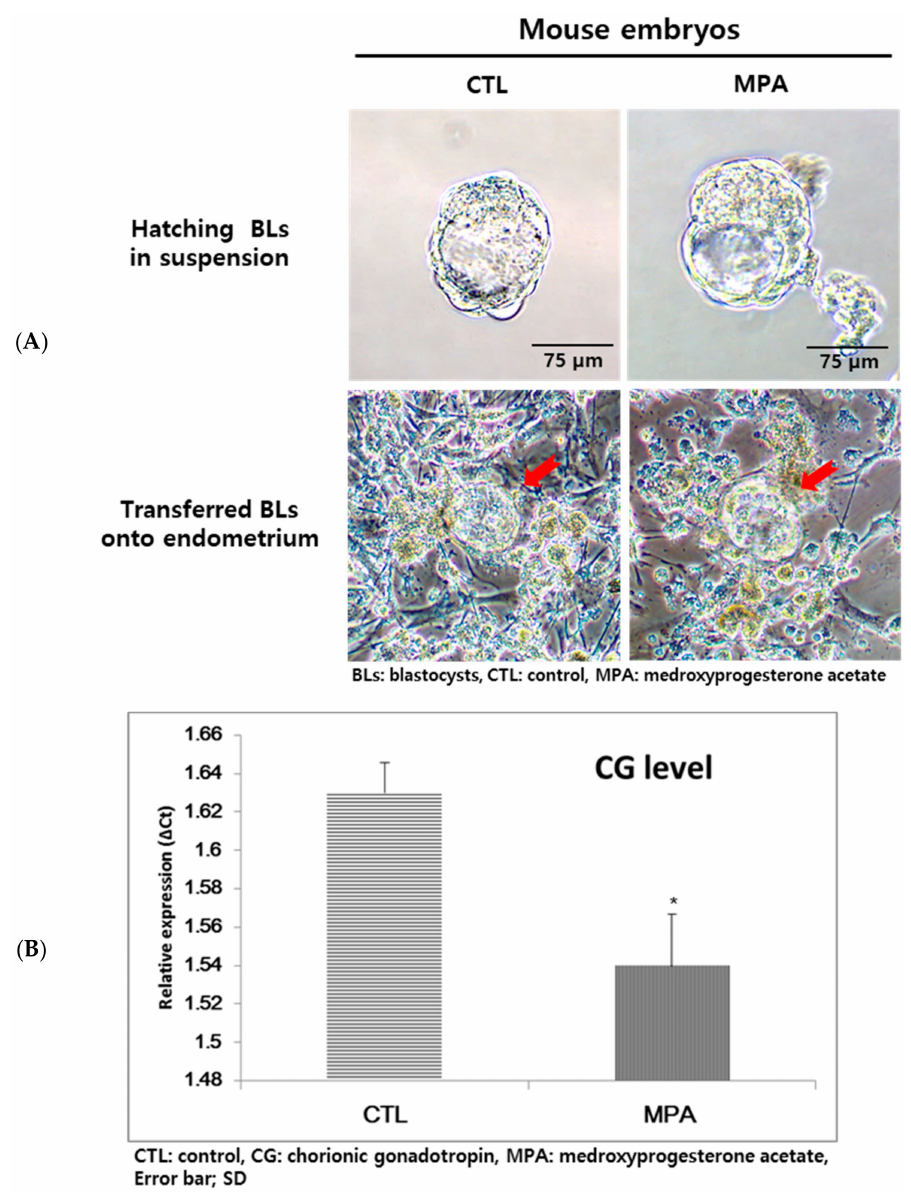
Figure 7. Chorionic gonadotropin (CG) expression of mouse embryos transferred onto autologous endometrial cells. ( A ) Mouse embryos transferred onto primary in vitro cultured endometrial cells did not show any di ff erent morphology according to MPA treatment at 10 − 7 M. The red arrow indicated mBLs. ( B ) The expression of CG was down-regulated in the MPA-treated group (* p <